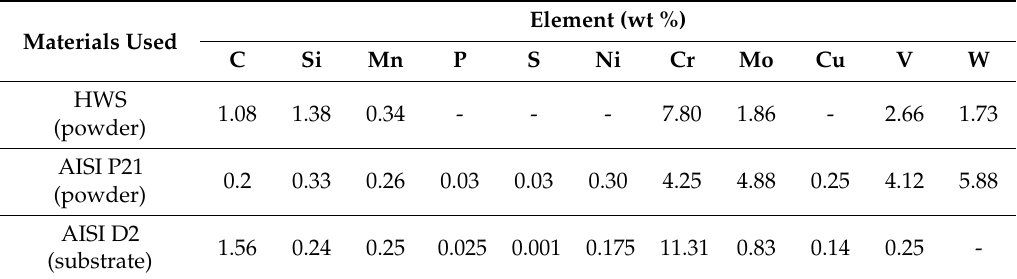
Table 2. Chemical composition of the main